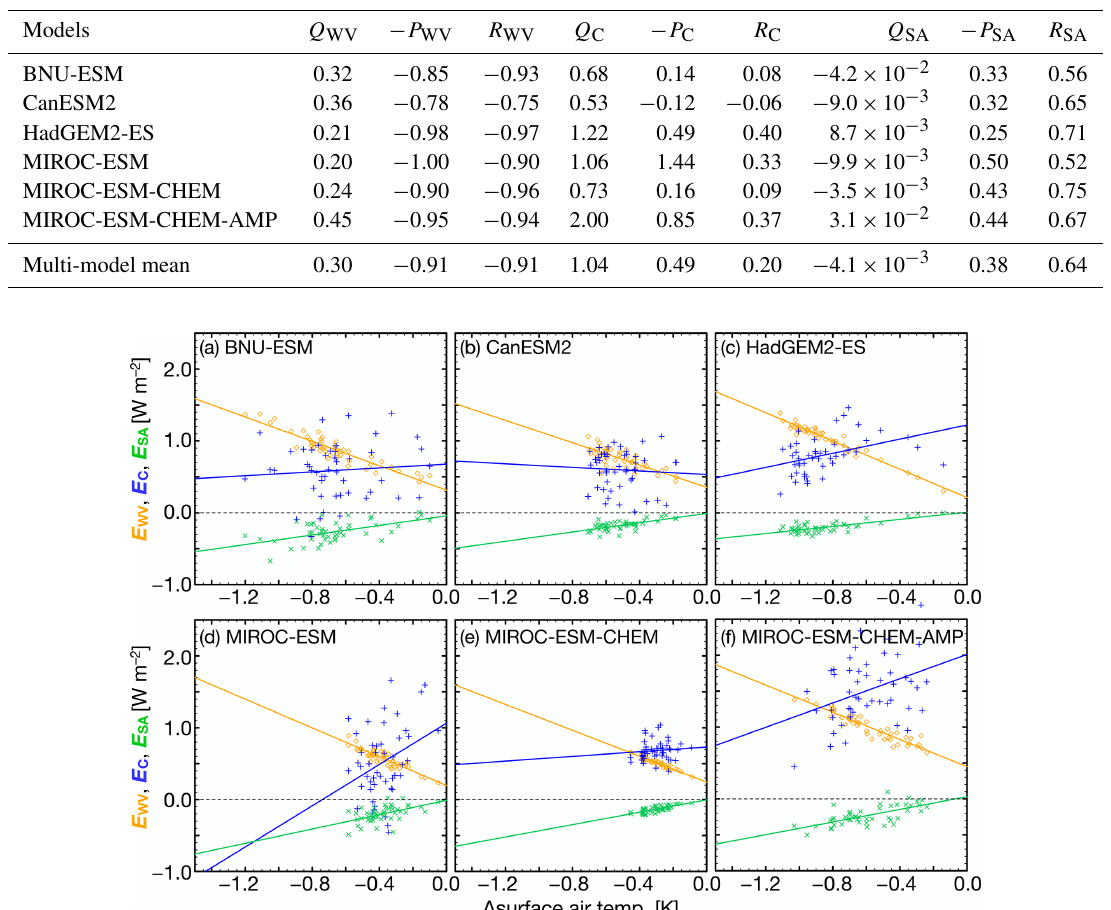
Figure 7. Globally and annually averaged relationship between (cid:49)T ( x axis) and E WV (orange (cid:5) ), E C (blue + ), and E SA (green × ) for each year from 2021 to 2069. Regression line for each plot is shown by the same colour, and a slope (feedback parameter), a y intercept (rapid adjustment), and a correlation coefficient for each plot are shown in Table 3. Ensemble mean data are used for the plots on (b)